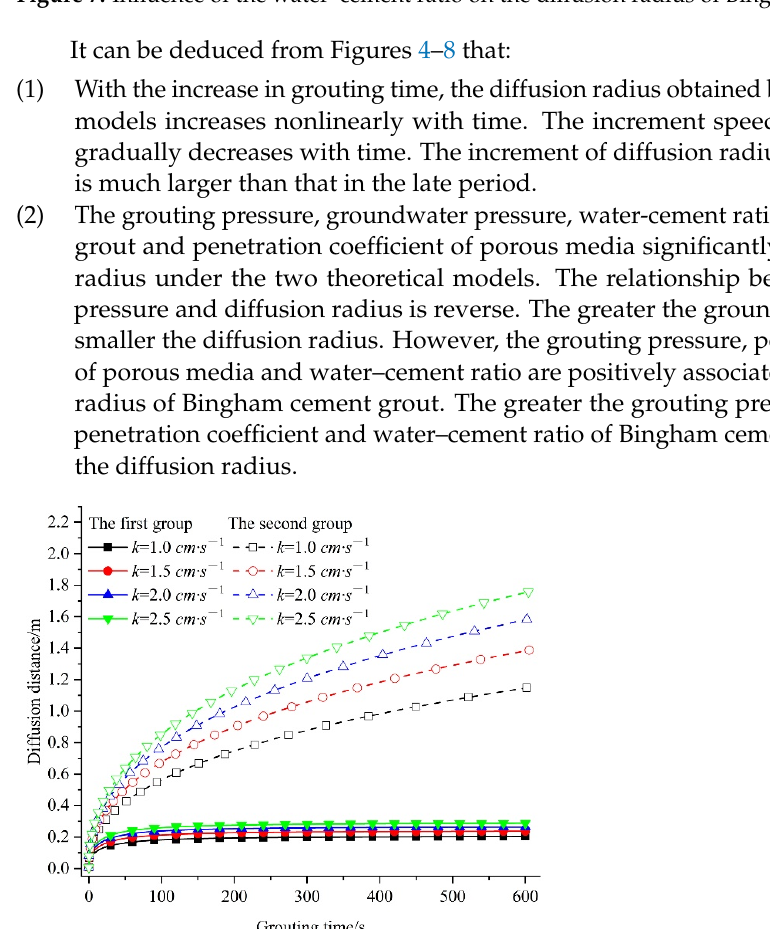
Figure 8. Influence of the penetration coefficient of porous media on the diffusion